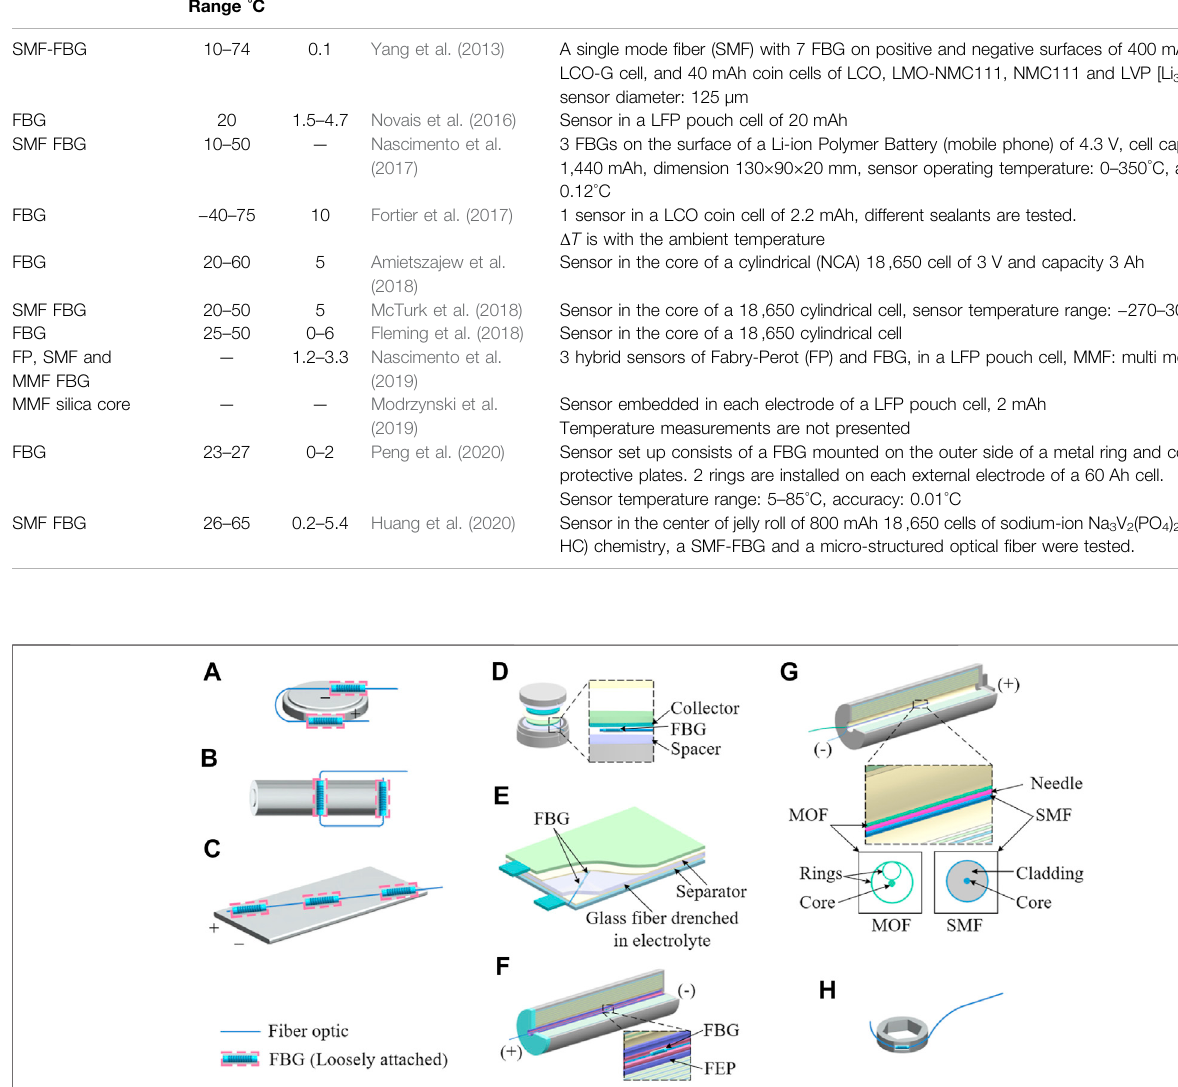
Frontiers in Chemical Engineering |